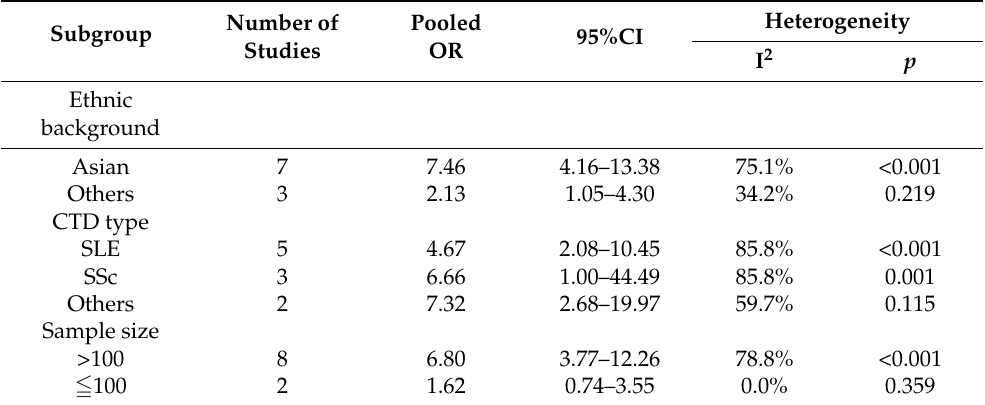
Figure 2. Forest plot of the relationship between anti-U1 RNP antibody and CTD-PAH [10,12,13,24– 29,31]. OR: odds ratio; CI: confidence interval. Table 2. Results of subgroup analysis of risk factor analysis. CTD: connective tissue disease; SLE: systemic lupus erythematosus; SSc: systemic sclerosis; OR: odds ratio; CI: confidence interval.